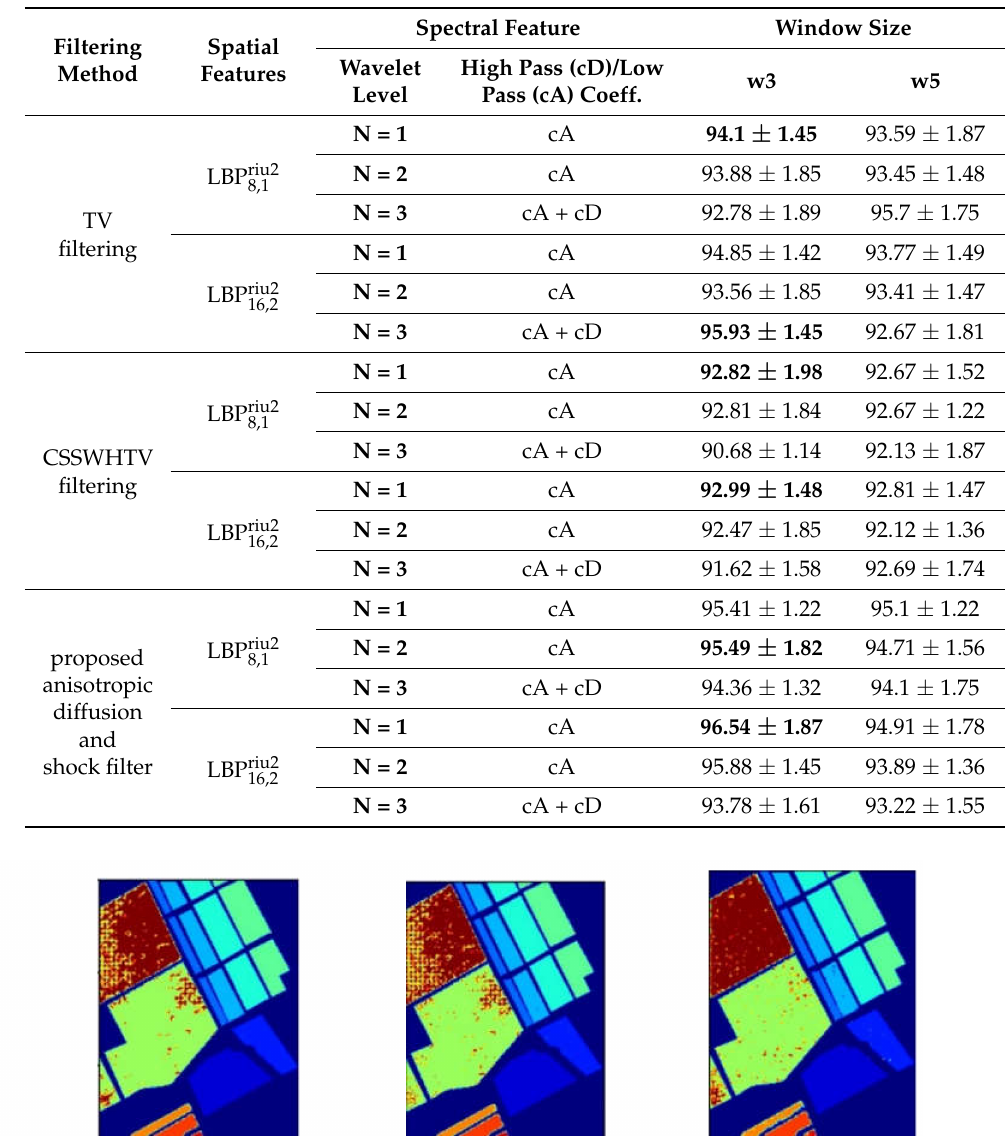
Table 7. Classification accuracy for the Salinas dataset, using the TV, the CSSWHTV and the anisotropic diffusion and shock filter-based approaches, with wavelet transform for three levels, with the corresponding window size, of dimension 3 × 3 and 5 × 5, for the controlled sampling strategy and LBP histogram computation, w3 and w5 (OA).